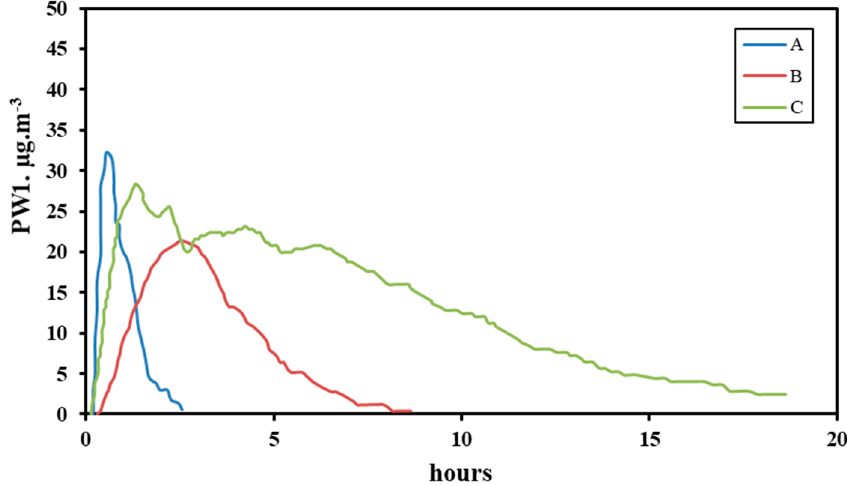
Figure 7. PM 1.0 concentration reduction vs time. A: fan with airflow 82.8 m 3 /h speed 5 B: fan with airflow 28.8 m 3 /h C: fan off adopted from [137] .